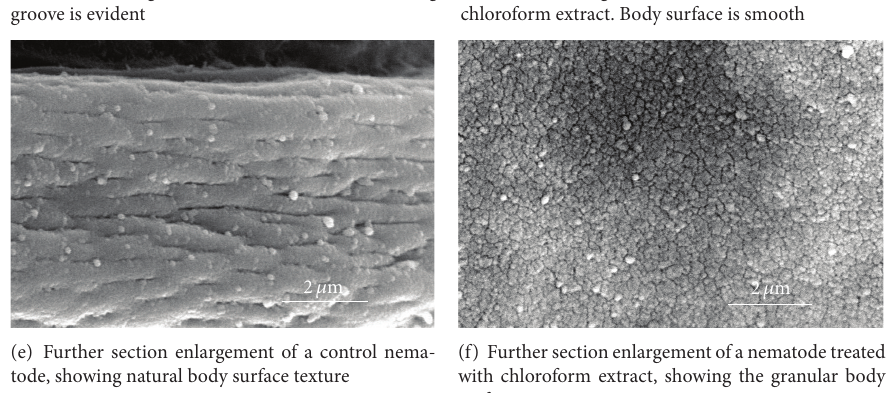
Figure 1: Scanning electron micrographs of Meloidogyne incognita (adult).